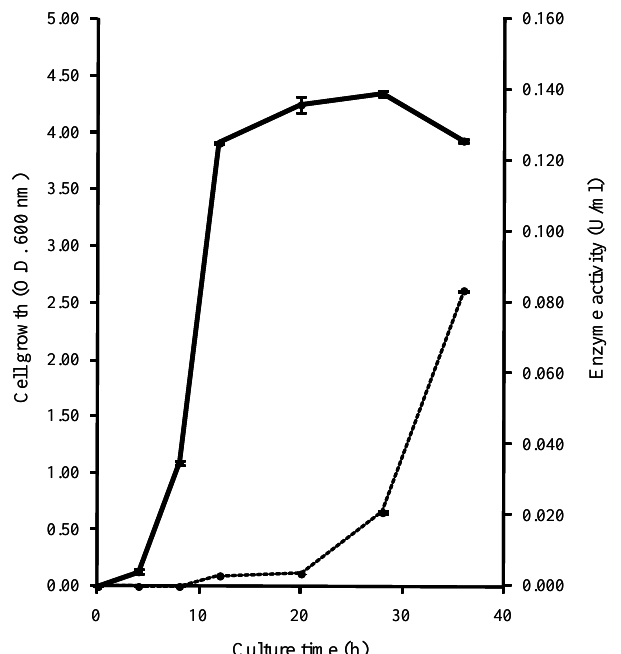
Figure 3. Growth and  -galactosidase production by Paenibacillus sp . LX-20. Symbols represent  -galactosidase activity (dotted line) and growth (solid line). Data were expressed as mean and standard errors from three